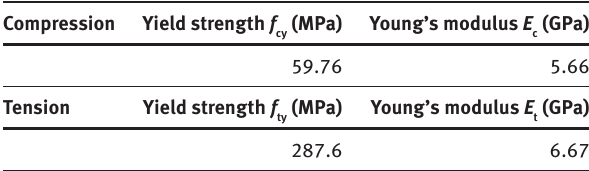
Table 3: Material properties of face sheet and web. Compression